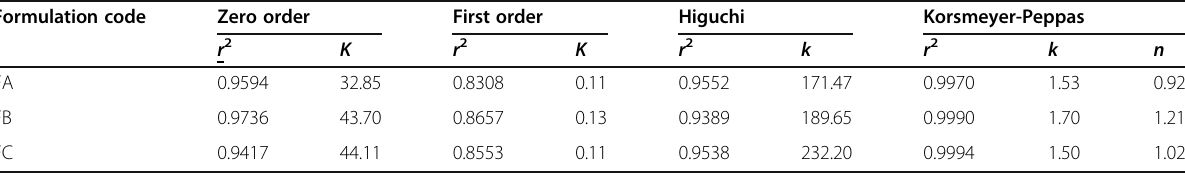
Table 5 In vitro release kinetic parameters of metformin from the microspheres Formulation